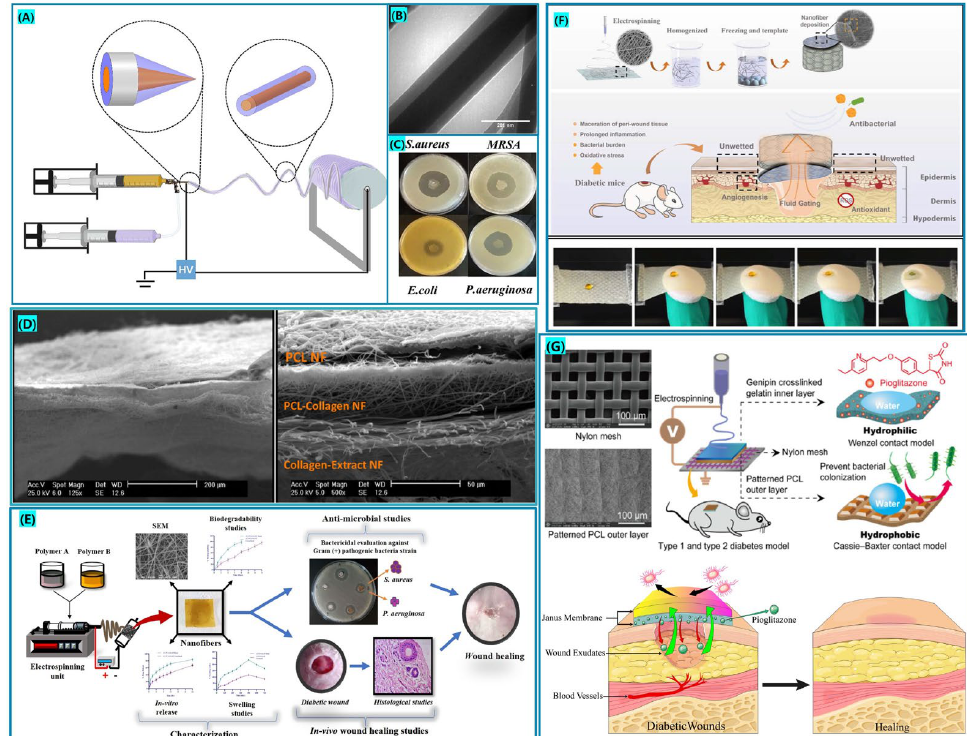
Figure 7. ( A ) Diagram of the fabrication of dual drug-carrying nanofiber membrane, approved cita-